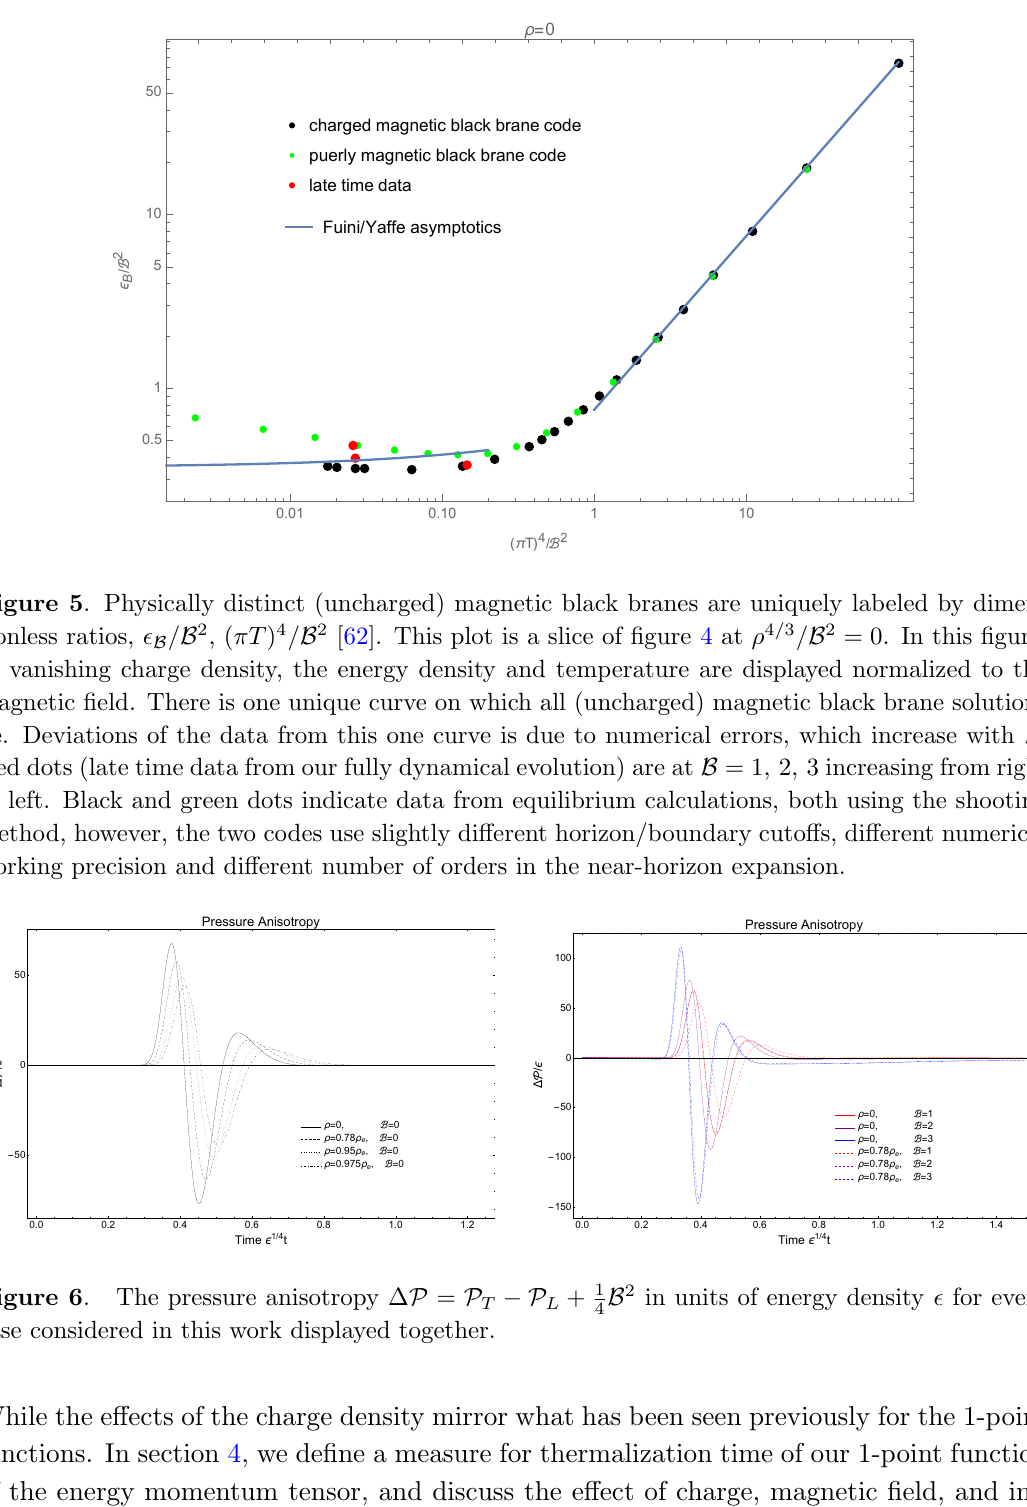
B 2 in units of energy density (cid:15) for every 4